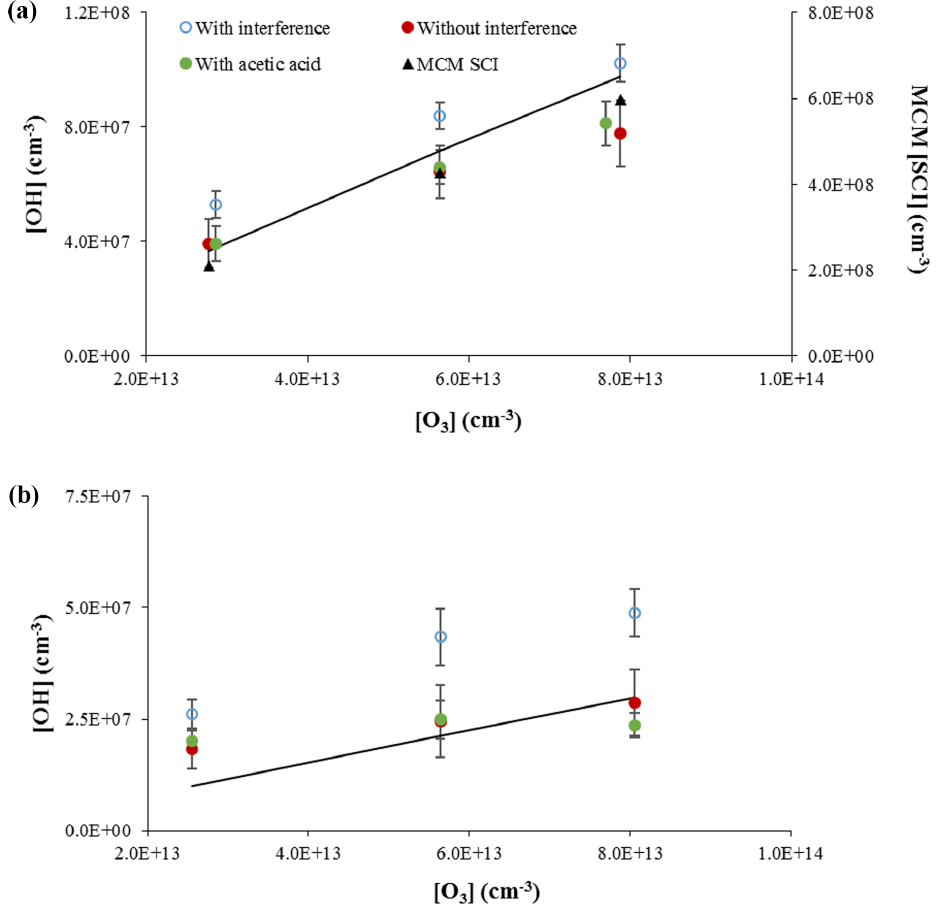
Figure 7. Measurements of OH concentrations from the ozonolysis of α -pinene (approximately 1 × 10 12 cm − 3 , a ) and ocimene (approxi- mately 4 × 10 11 cm − 3 , b ). Open symbols are measurements including the interference, filled red circles are the resulting OH measurements when the interference determined by C 3 F 6 addition is subtracted, and the filled green circles are the OH measurements when acetic acid is added to the flow tube. The lines indicate the expected OH concentration from published OH yields. The black triangles in the top plot reflect the predicted concentration of stabilized Criegee intermediates by the Master Chemical Mechanism (MCM SCI; see